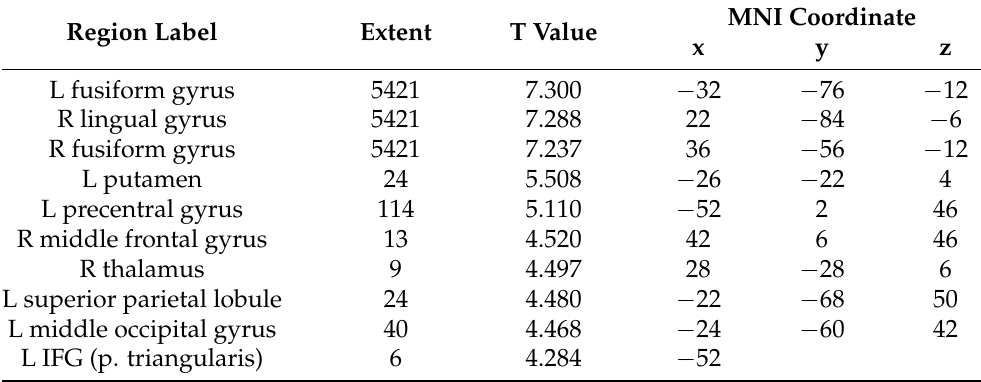
Figure 3. Whole brain activation patterns for the AD group ( p value < 0.001, uncorrected). Table 3. Activation of brain regions for the AD group ( p value < 0.001,